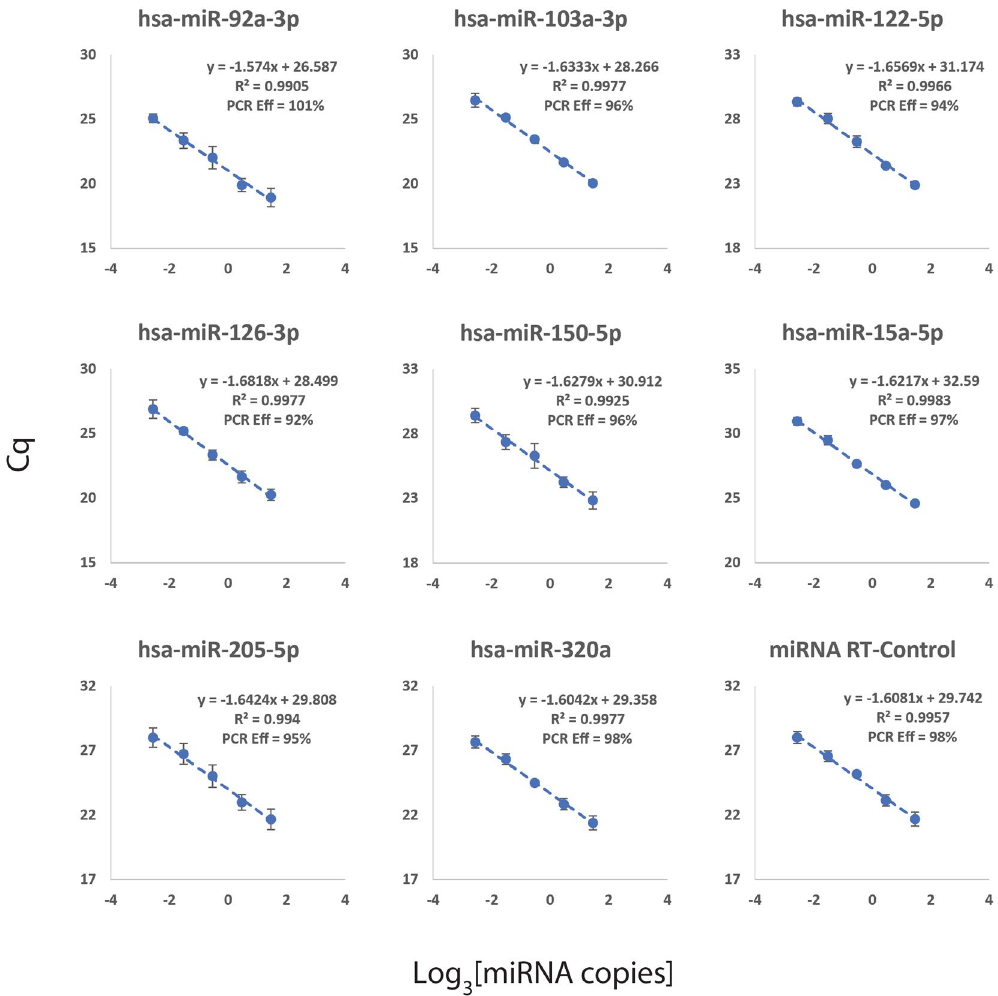
Figure 1. PCR efficiency of 9 representative miRNA assays on miRSCan ™ PanCancer Chips. Real-time qPCR was carried out for each miRNA cluster using 3-fold serially diluted cDNA template synthesized from Universal Human miRNA Reference RNA (UHmiRR; miRQC A). The resulting Cq values were plotted against the respective miRNA concentrations to derive the PCR efficiency for each assay. All 9 assays fell within acceptable PCR efficiency of